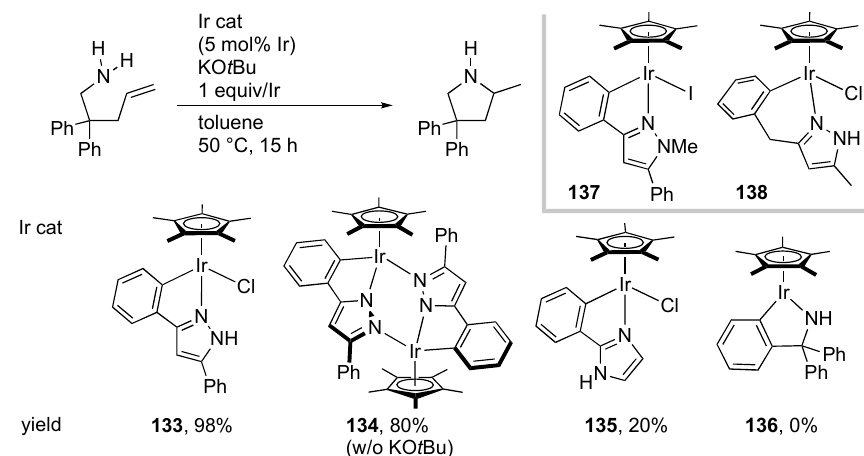
Scheme 52. Cyclization of an aminoalkene catalyzed by iridium complexes.